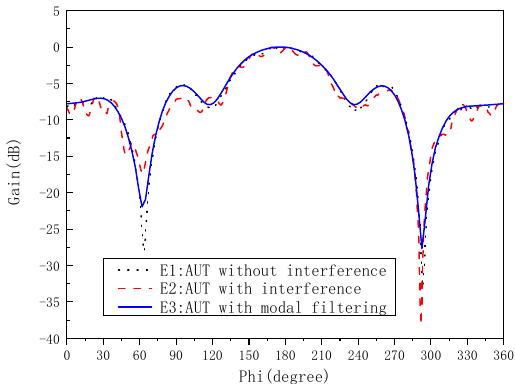
Figure 9. Comparison of the antenna pattern before filtering and after filtering. It can be seen from Figure 9 that, for the antenna pattern including the reflection interference from the metal plate, the modal filtering technology eliminates the disturbance of the main lobe and the back lobe; 2.5 dB interference is filtered out at the − 10 dB level, which greatly improves the measurement accuracy of the antenna. 2 . Experiment Ⅱ The AUT works at 6 GHz and the interference object is a metal ball with a radius of 140 mm (2.8 λ 2), λ 2 = 50 mm, which is placed on interference position 2 shown in Figure 6, as shown in Figure 10 below. The distance between the probe and the antenna under test is 6000 mm (120 λ 2) and the probe is in the far-field radiation region of the antenna under test. The experimental equipment and procedure are the same as in Experiment Ⅰ . Figure 10. Experiment Ⅱ test scene. The processing steps of modal filtering are the same as those of experiment Ⅰ . In this experiment, the wideband antenna to be tested is at a different operating frequency of 6 GHz, so the number of mode terms corresponding to the smallest spherical wave surrounding the antenna has changed compared with before, N2 = [k2 × r0] = 7, k2 = 2 π / λ 2. Taking the first seven items in the spherical wave expansion mode items of the interference electric field E4 with the presence of metal balls, the interference can be suppressed and the filtered antenna pattern E5 can be obtained. The analysis and comparison of the antenna pattern E1 without interference, the antenna pattern E4 with metal balls, and the field E5 after modal filtering of the electric field E4 are shown in Figure 11 below.